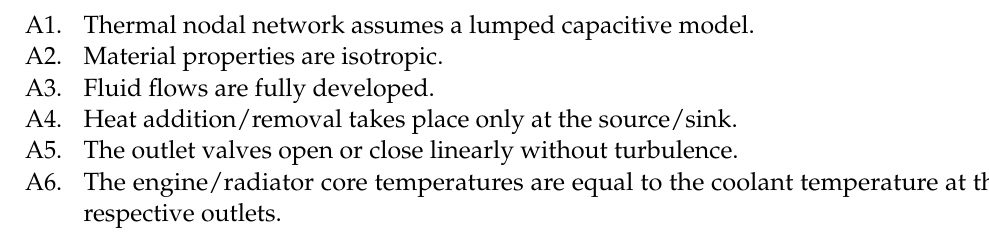
Figure 1. Architecture layout of the proposed multi-radiator thermal management system.